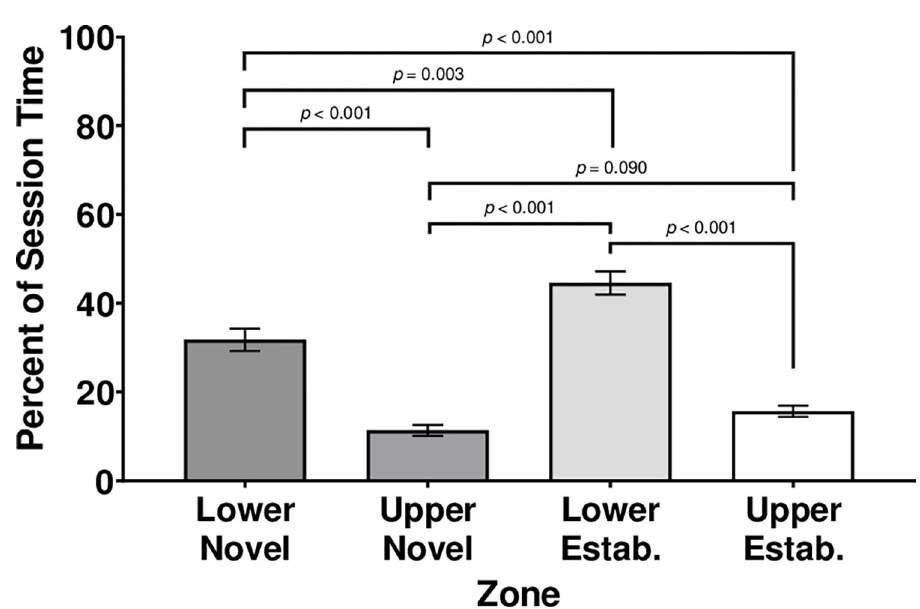
Fig 3. Percent cumulative duration in each quadrant zone across both sexes. Quadrants are labeled as upper/lower sections of the tank and novel/established stimulus shoal proximity. Error bars are +/- SEM . While exact p- values are reported for post-hoc comparisons, p- values smaller than 0.001 are indicated as p < 0.001.